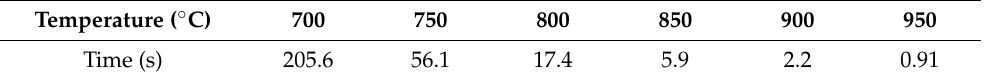
Table 5. Time required for complete decarburization was predicted using the kinetic Equation